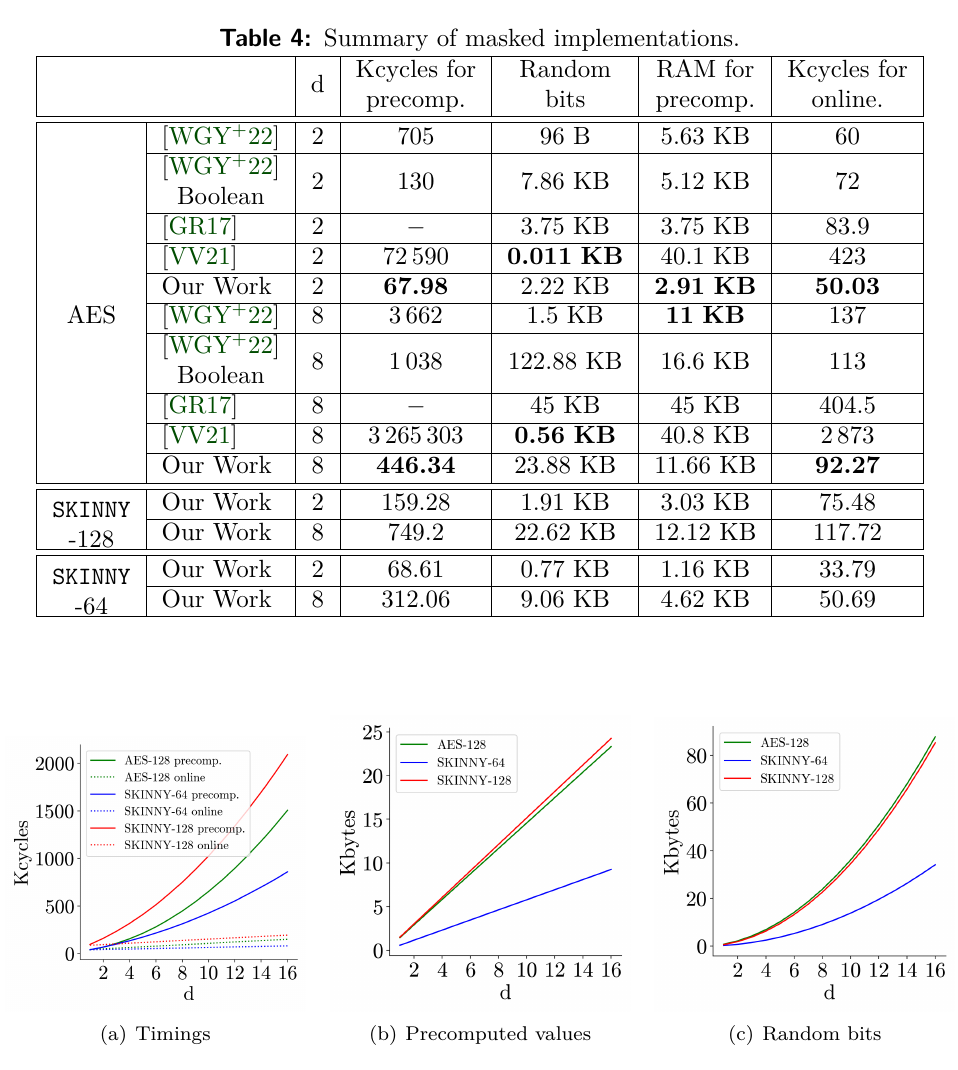
Figure 4: Performance trend for d = [1 :